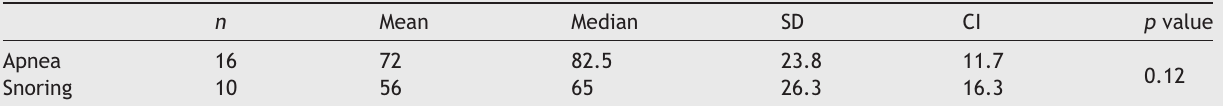
Comparison between apnea and snoring groups regarding the size of the adenoids (%).